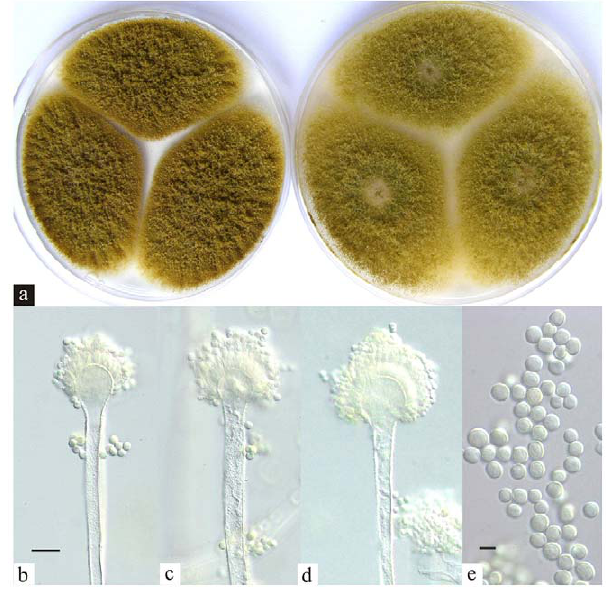
Figure 4. Aspergillus bertholletius. (a) Colonies on Czapek yeast extract agar and malt extract agar after 7 days incubation at 25 u C; (b, c, d) conidial heads, bar=10 m m; (d) conidia, bar=5 m m.